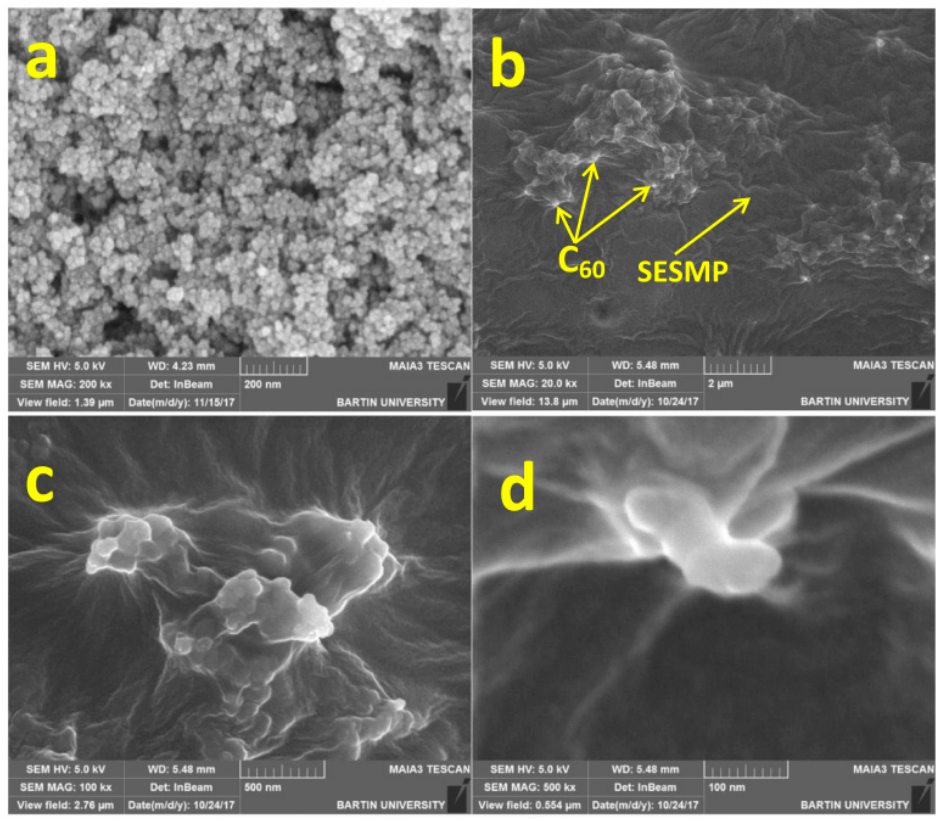
Figure 1. SEM of ( a ) Fe 3 O 4 -NPs, ( b ) C 60 -SESMP nanocomposite 2 μ m, ( c ) C 60 -SESMP nanocomposite 500 nm, and ( d ) C 60 -SESMP nanocomposite 100 nm. Reprinted with permission from Ref. [48]. Copyright (2019) Elsevier.